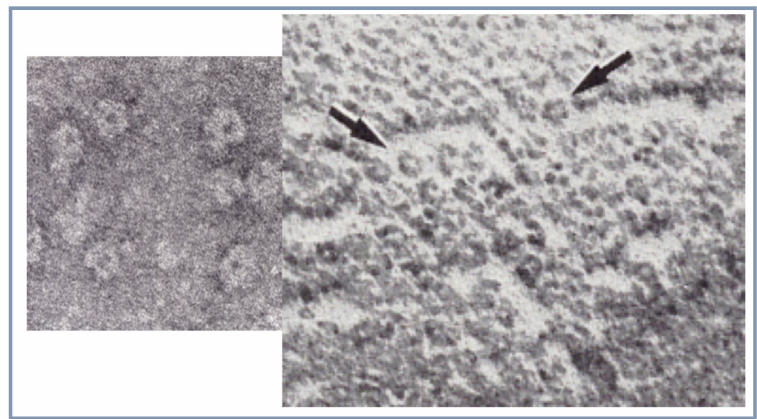
Figure 8. First EM visualisation of the AChR protein: left detergent purified AChR protein from E.electricus and right AChR-rich membranes from T. marmorata . The arrows indicate possible pentameric structures (reproduced from